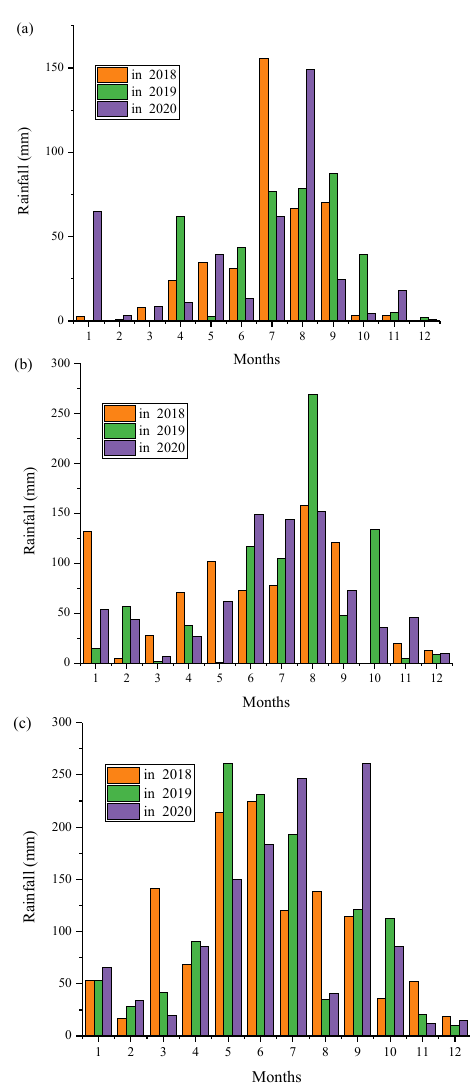
Figure 4. Annual rainfall distribution in different regions and years: ( a ) 400 mm: Taiyuan, in 2018, 2019, and 2020; ( b ) 800 mm: Zhengzhou, in 2018, 2019, and 2020; ( c ) 1200 mm: Guiyang, in 2018, 2019, and 2020.